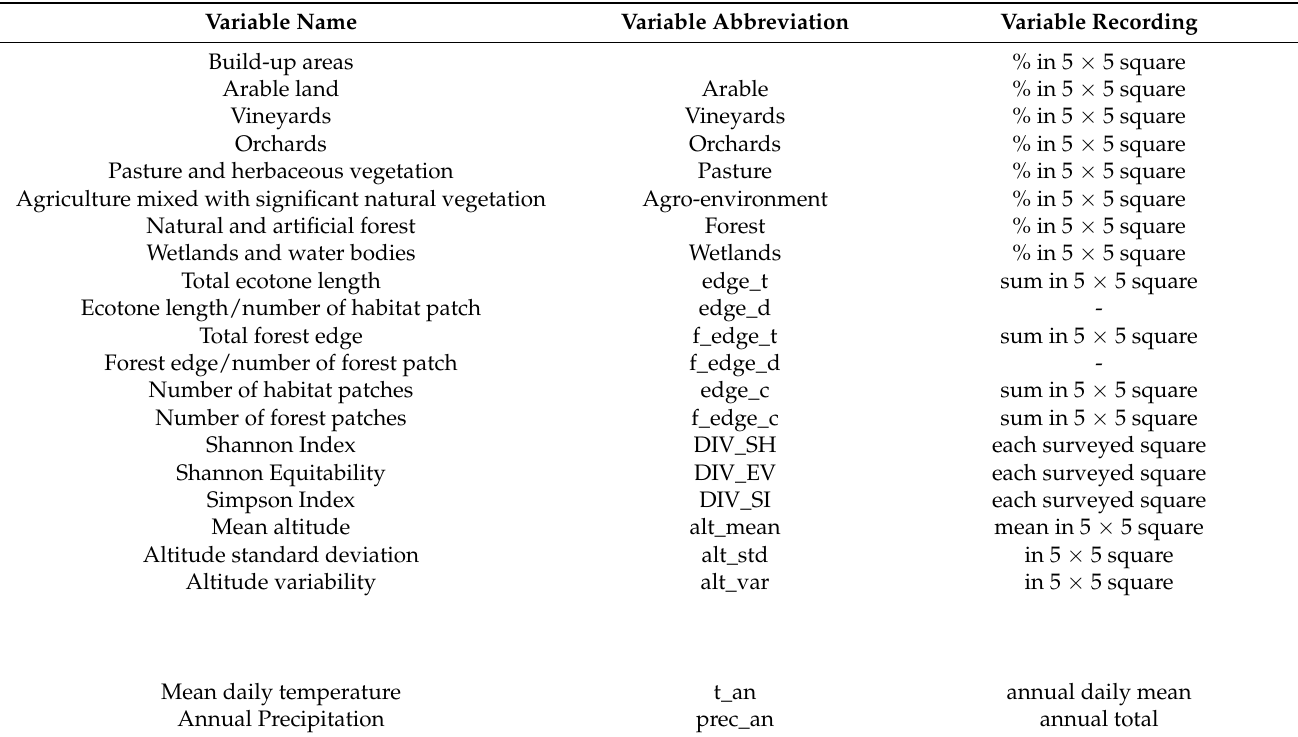
Table 1. Landscape and climatic data used for a Generalized Linear Mixed Model (GLMM) approach to determine its influence on the Common Buzzard’s breeding abundance in Eastern